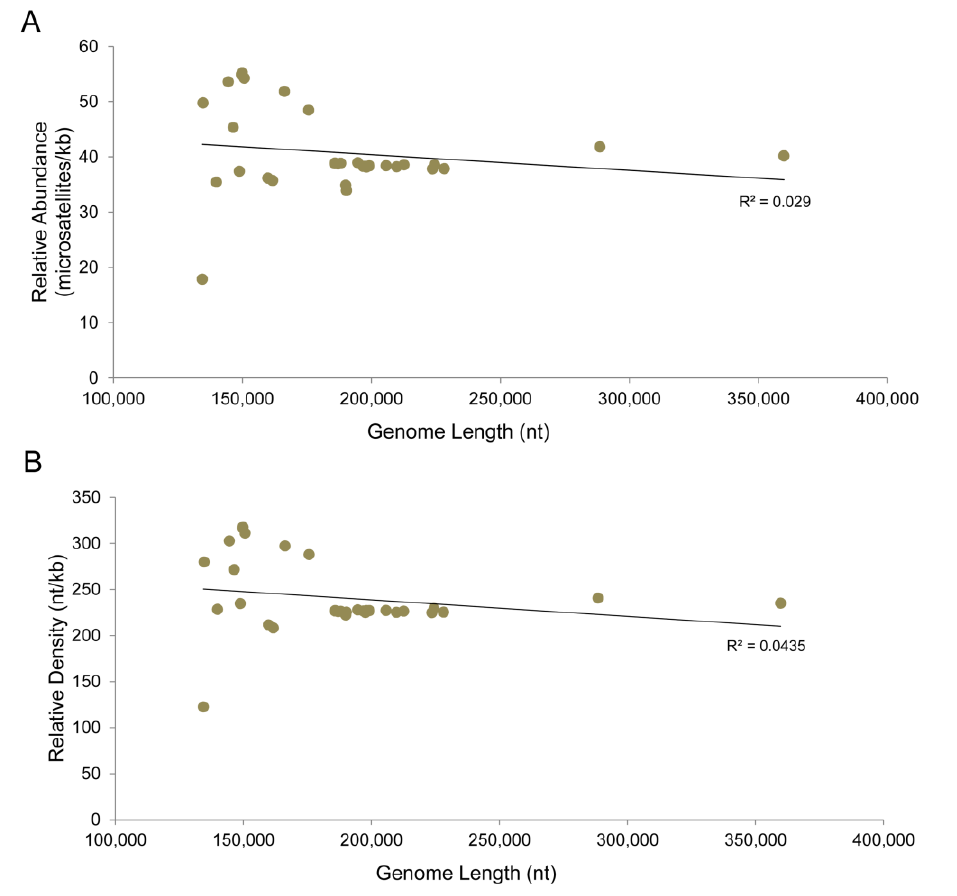
Figure 6. Genome length is not correlated with microsatellite abundance or density. ( a ) RA and ( b ) RD are shown for each isolate, plotted versus genomic length.